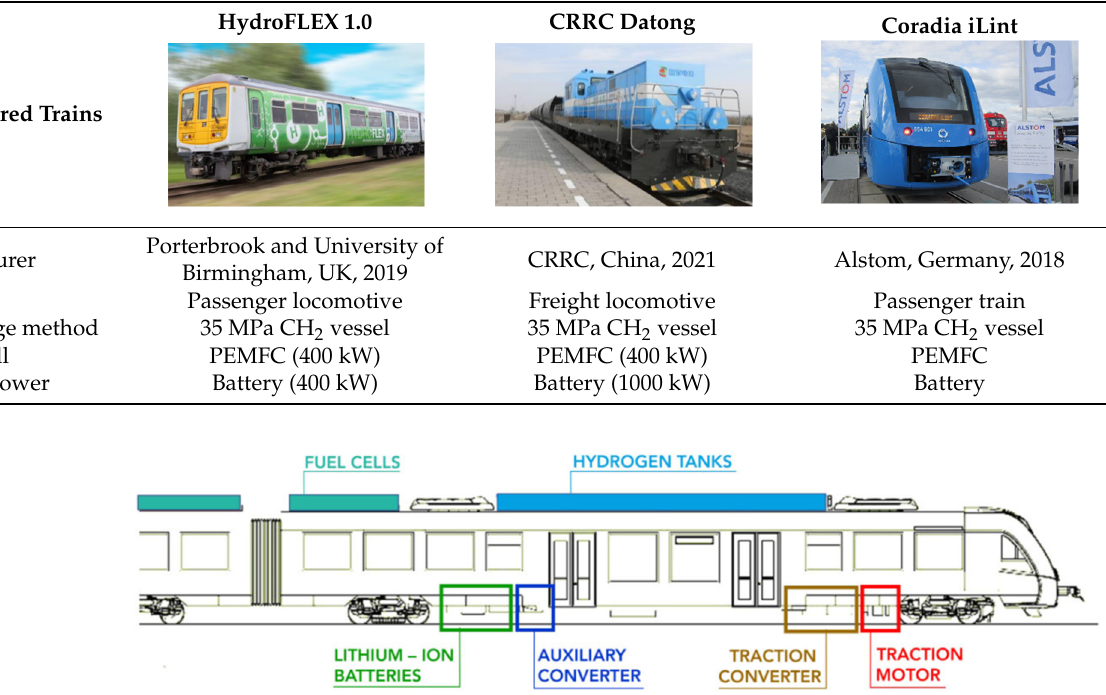
Table 3. Recently revealed hydrogen-powered trains.